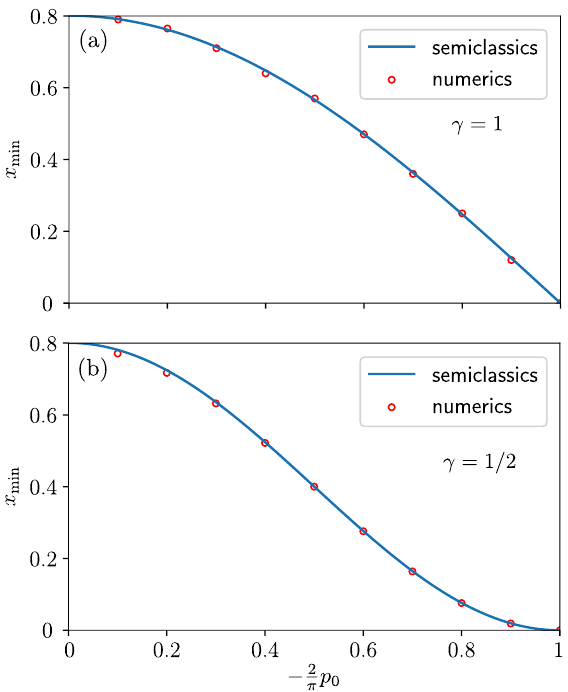
Figure 5: The turning point x law hopping with (a) γ = 1 and (b) γ = 1 / 2. Red circles are the numerical results while solid lines indicate the semiclassical expression x